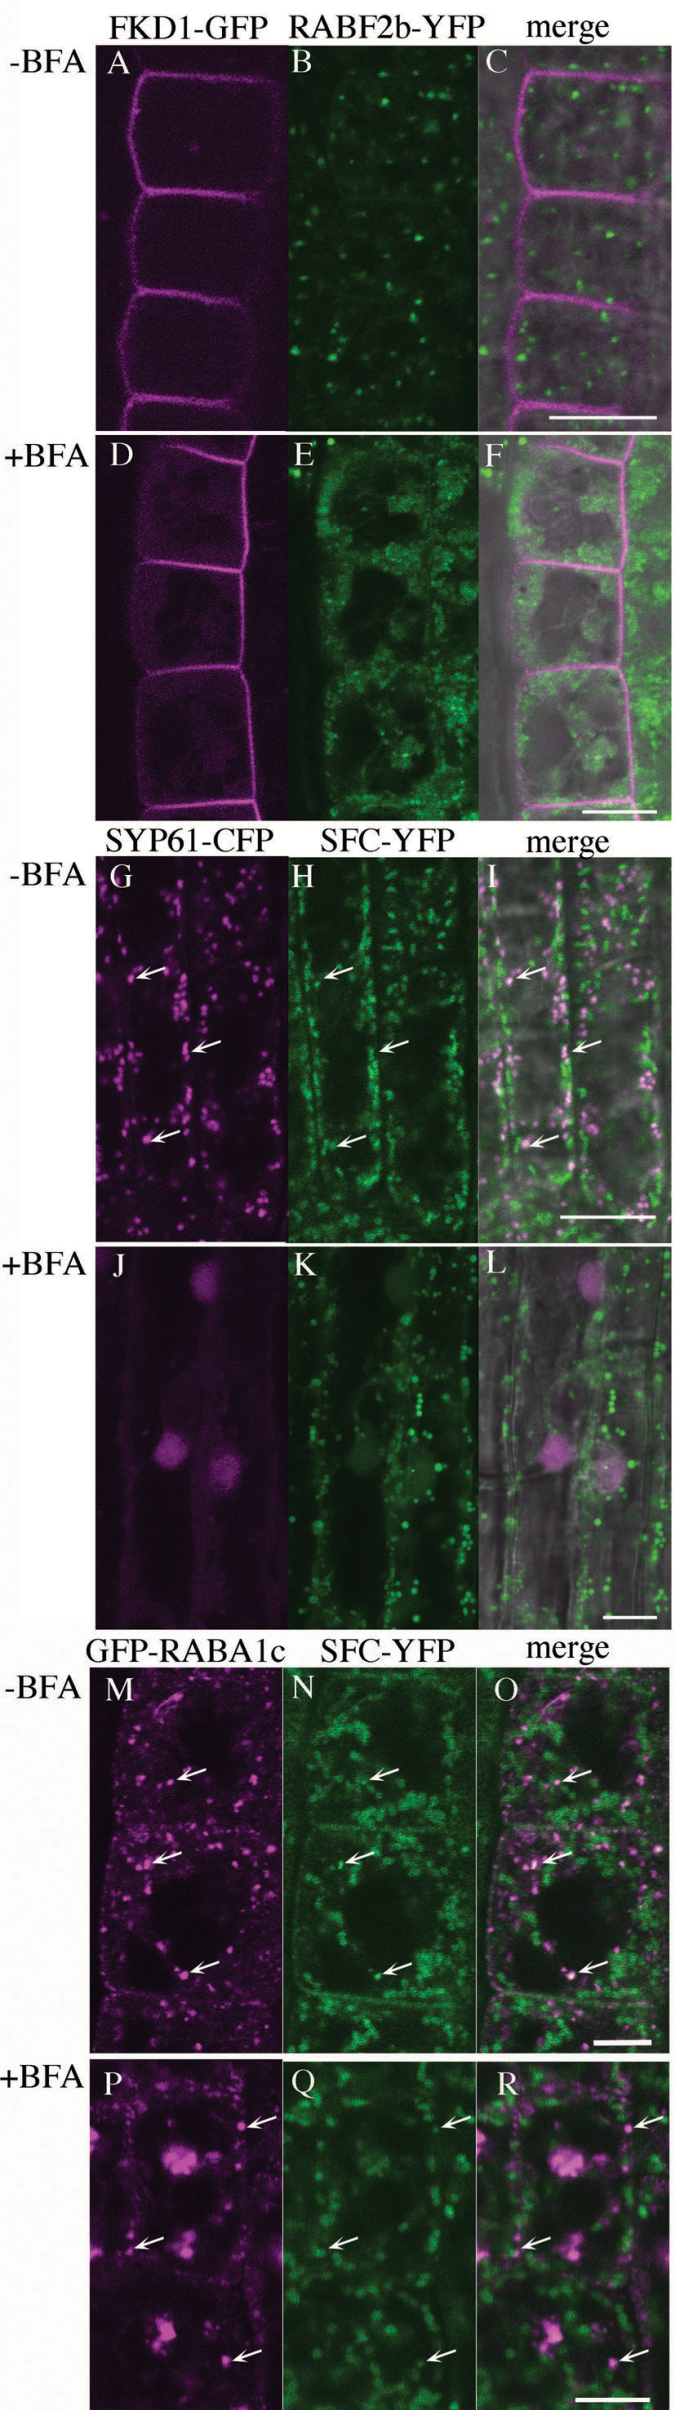
35S:FKD1–GFP and 35S:SFC–YFP compartments are unaffected by BFA treatment. Localization of 35S:FKD1–GFP with UBQ10:RABF2b–YFP (A–F), 35S:SFC–YFP with SYP61pro:SYP61–CFP (G–L), or 35S:SFC–YFP with 35S:GFP–RABA1c in Arabidopsis root epidermal cells treated with DMSO (A–C; G–I; M–O) or 50 μM BFA in DMSO (D–F; J–L, P–R). (A and D) 35S:FKD1–GFP alone; (H), (K), (N), and (O) 35S:SFC–YFP alone; (B and E) UBQ10:RABF2b–YFP alone, (G and J) SYP61pro:SYP61–CFP alone; (M and P) 35S:GFP–RABA1c alone; (C), (F), (I), (L), (O), and (R) merged images. Arrows in (G–I) and (M–R) indicate co-localization of the two labels. Scale bar=5 μm.